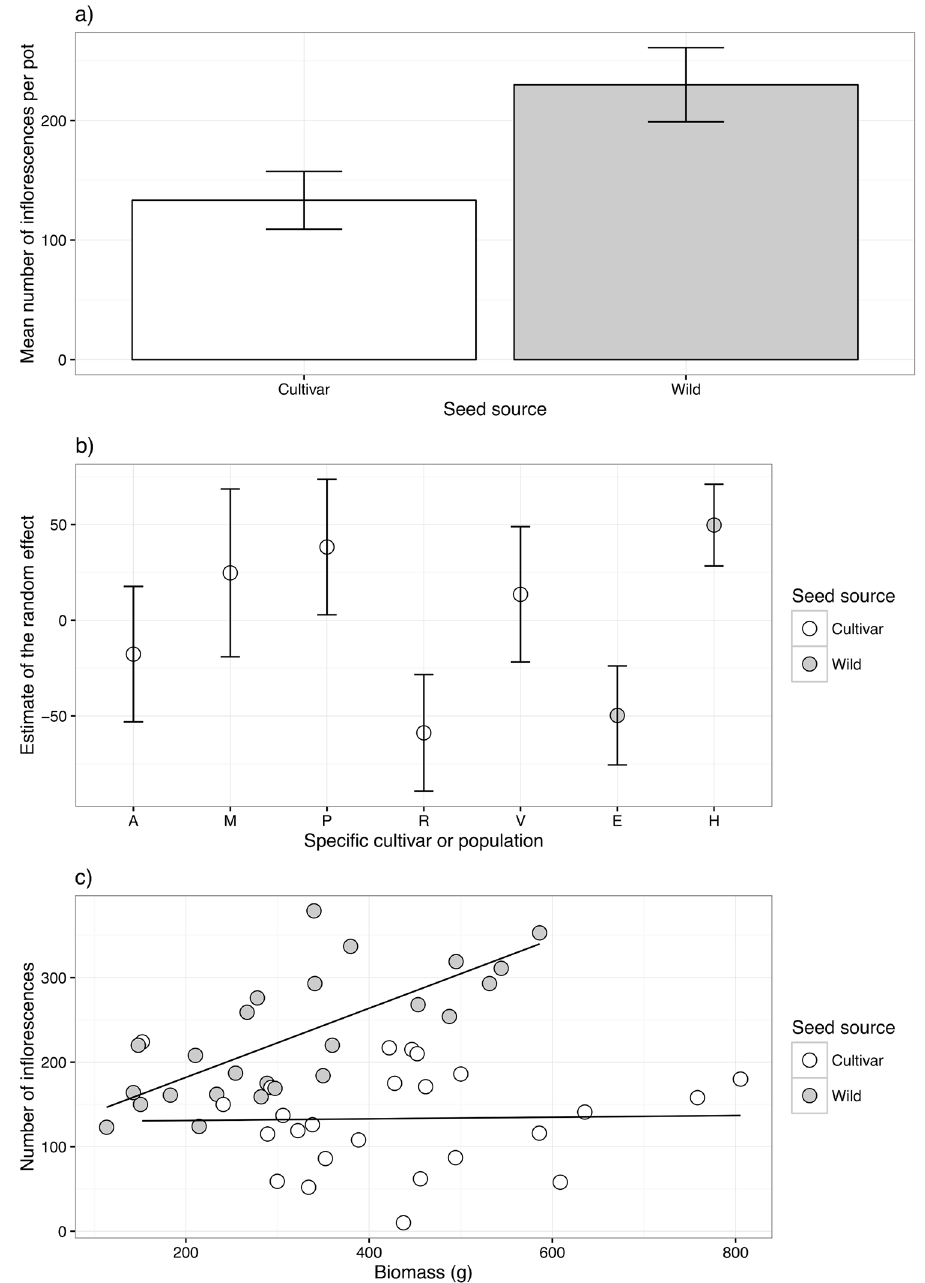
Fig 2. (a) Mean total abundance of inflorescences produced per pot for the cultivar (white) and wild (grey) treatments with 95% confidence intervals. (b) Estimate of the random effect for each specific cultivar (white) and wild population (grey) with 95% confidence intervals. (c) The relationship between biomass (g) and number of inflorescences produced within each pot. Cultivars are shown in white and wild populations in grey. Lines are fitted linear regressions. There is a significant relationship between biomass and inflorescence number for the wild populations (p = 2.4 x 10 − 5 ), but not for the cultivars (p = 0.90).